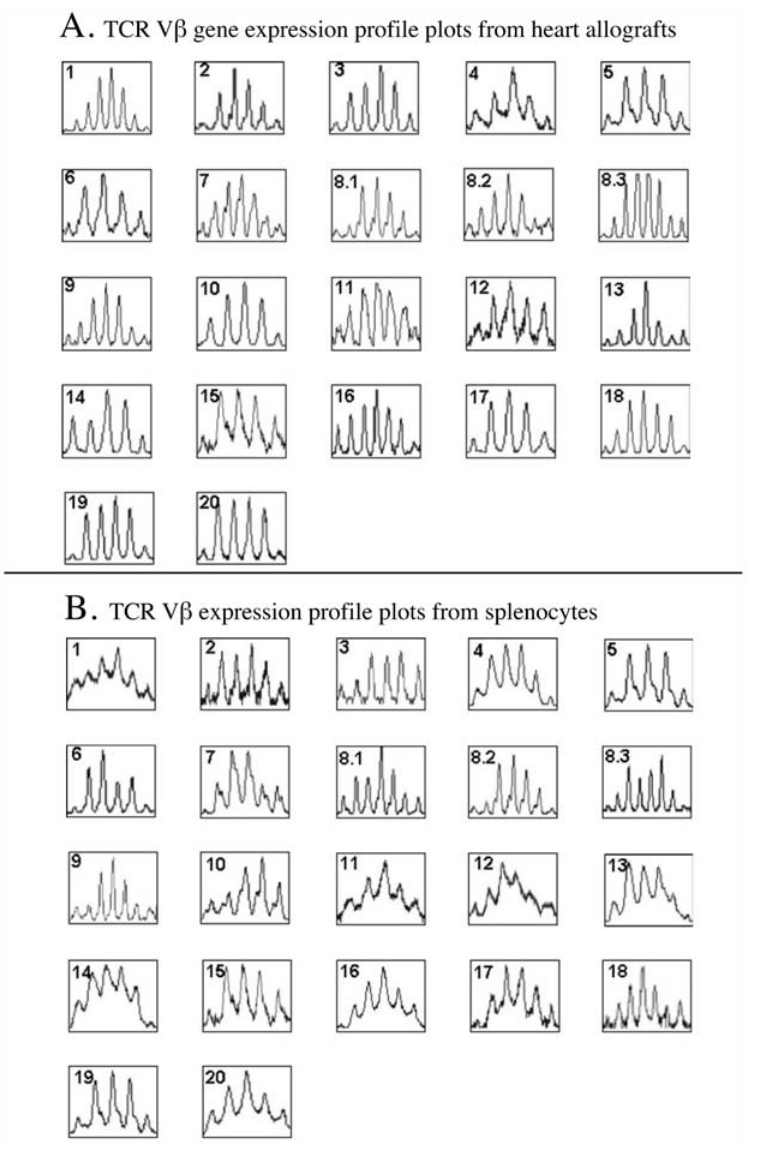
Figure 1. RT-PCR-assisted detection of expression profile of 22 known rat TCR V b genes in CsA-induced long-term tolerant ACI recipients bearing WF heart allografts (survival day . 100). (A) TCR V b gene expression profile plots from heart allografts. A fluorochrome- labeled primer derived from b chain constant region was used for run-off reactions for each V b -specific RT-PCR product, and the fluorescent run-off products were analyzed in 3700 DNA Analyzer, as described in Materials and Methods . Panel numbers correspond to the numbers of individual V b genes. (B) TCR V b expression profile plots from splenocytes.